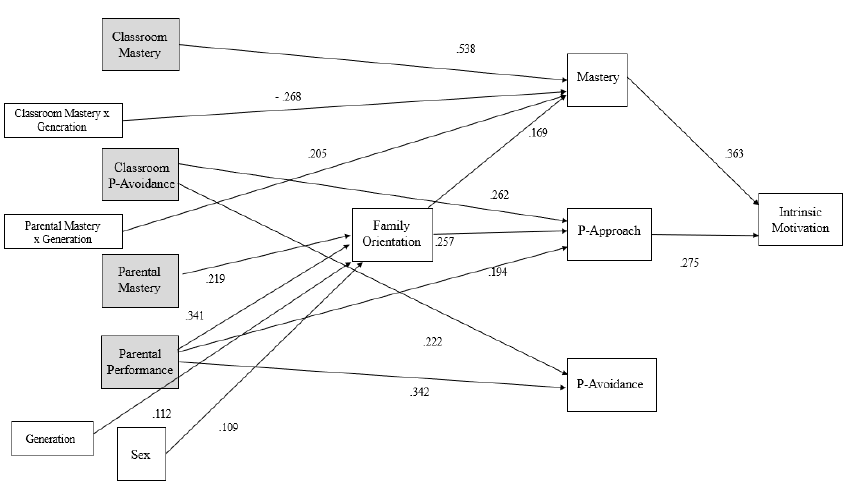
Figure 1 . Path analysis results with significant standardized path coefficients. This shows the associations among students’ perceptions of classroom goal structures, parental goals, family orientations, personal goals, and intrinsic motivations. Note. All paths presented in Figure 1 are significant at the p < .05